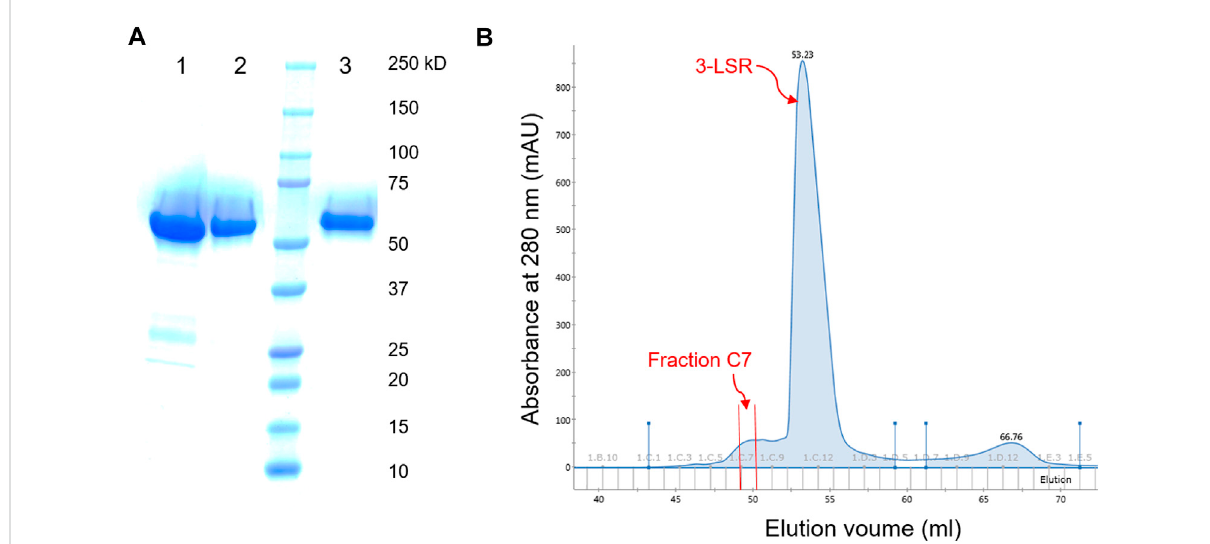
FIGURE 2 (A) SDS-PAGE of the 3-LSR after puri fi cation by Histrap (lane 1), anion-exchange (lane 2) and size exclusion (lane 3) chromatography. (B) Chromatogram of anion exchange puri fi cation of 3-LSR; the fraction with Flavin reductase activity (Fraction C7) eluted before elution of the 3-LSR protein (the main